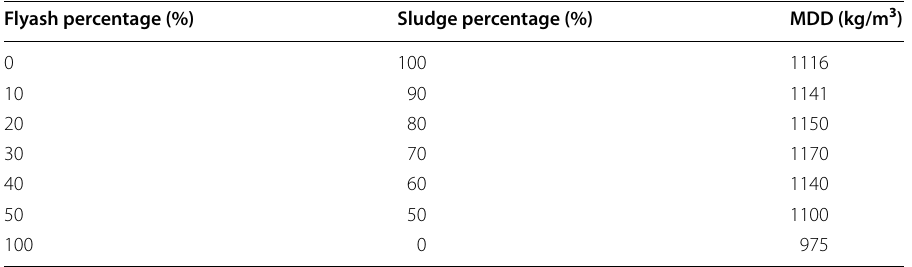
Table 4 MDD values for different mix proportions of flys ash and sludge Flyash percentage